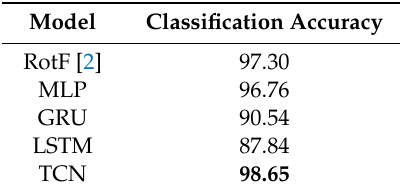
Table 2. Classification accuracy (%) of di ff erent models on the test dataset.